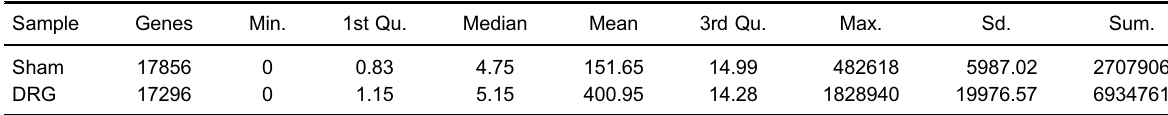
Table 3. Number and distribution of known gene expression.